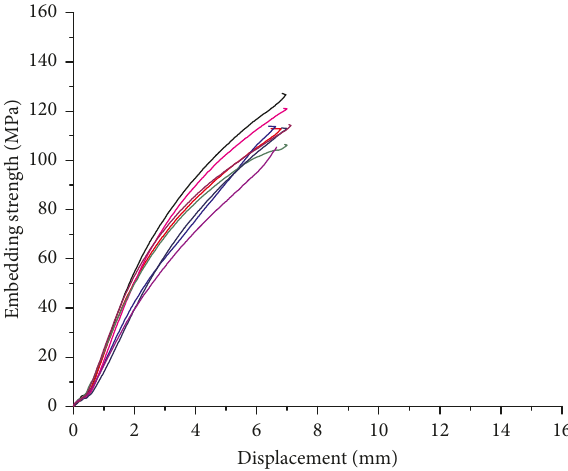
Figure 6: Method to evaluate the yielding load.